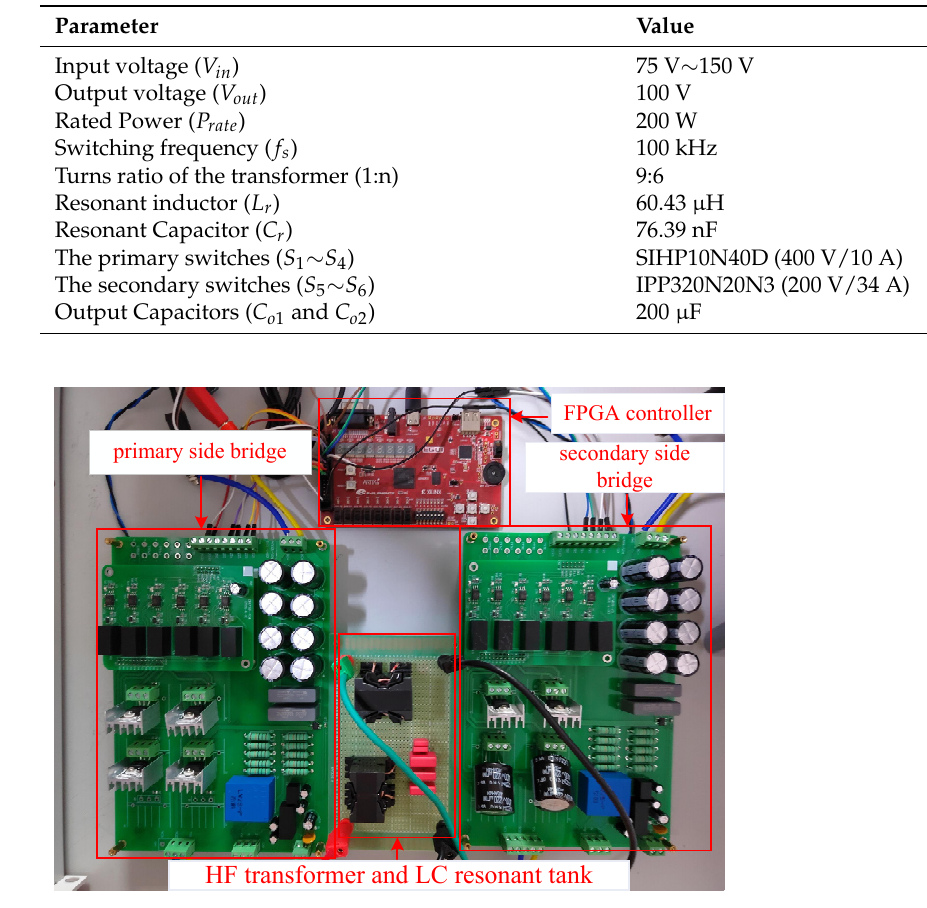
Figure 13. Picture of the designed